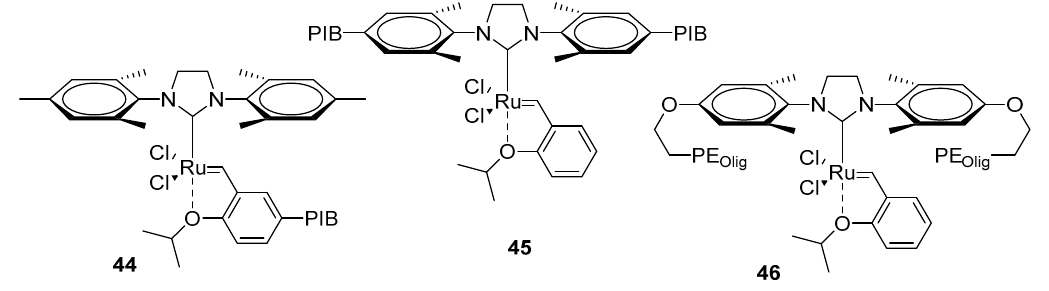
Figure 10. Polyolefin-supported Hoveyda-Grubbs catalysts 44 – 46 .